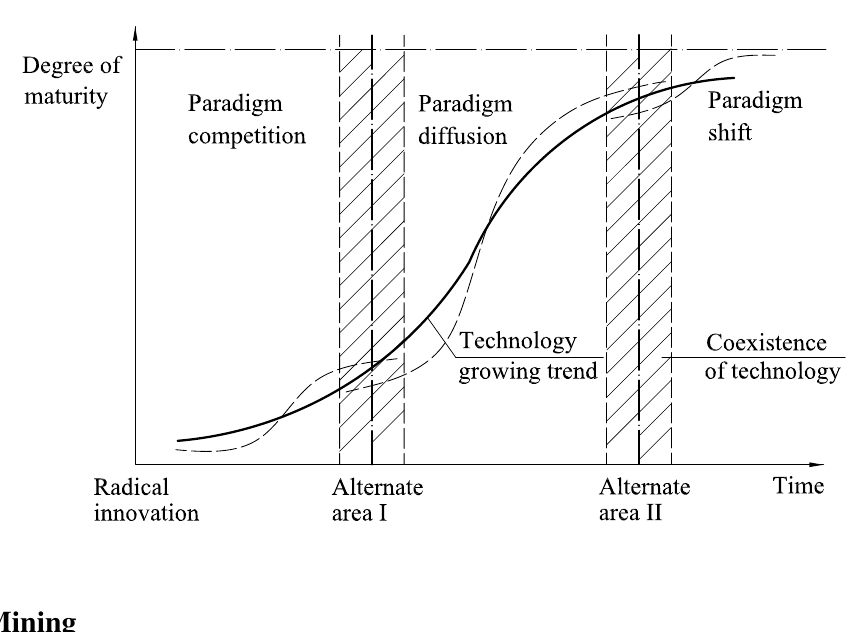
Figure 2. The growing trend of the